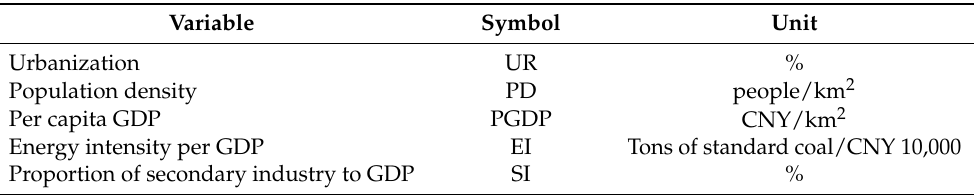
Figure 1. The locations of the three regions in China; the highlighted square in the right corner is “South China Sea territory map”. Table 1. Socioeconomic factors analyzed as potential driving force factors for the spatial variation in anthropogenic PM 2.5 concentrations.